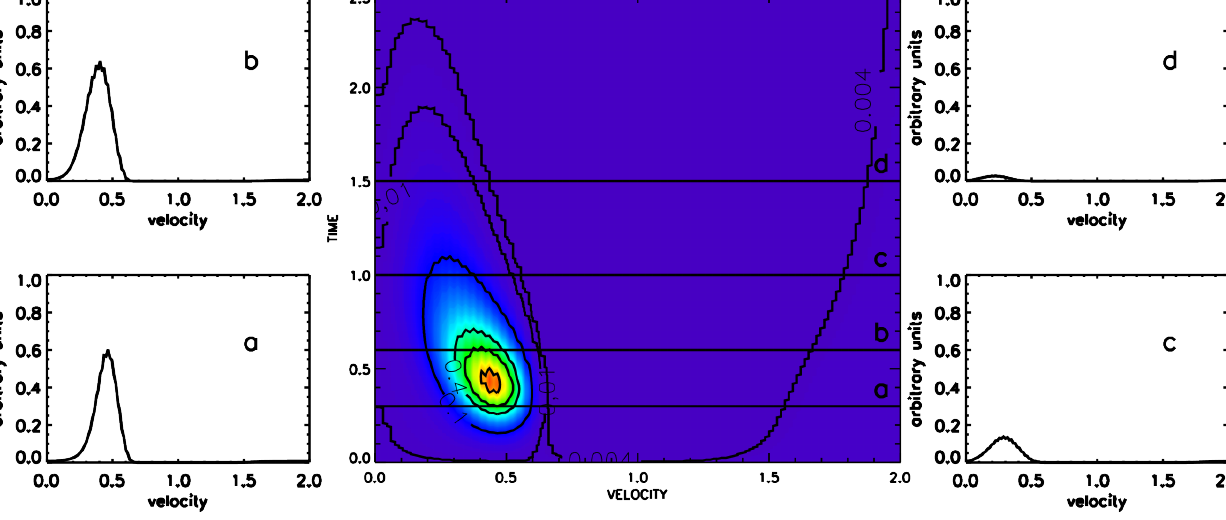
Fig. 2. The dynamics of the averaged wave spectral power obtained using the numerical simulation, as shown in the central panel. Small panels provide snapshots of the wave spectral power. The values of the wave spectral power and the velocity are provided in arbitrary units (in the Appendix following Eq.